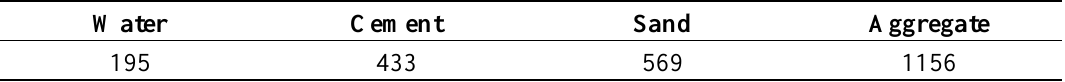
Table 1. Mixture proportions of the concrete